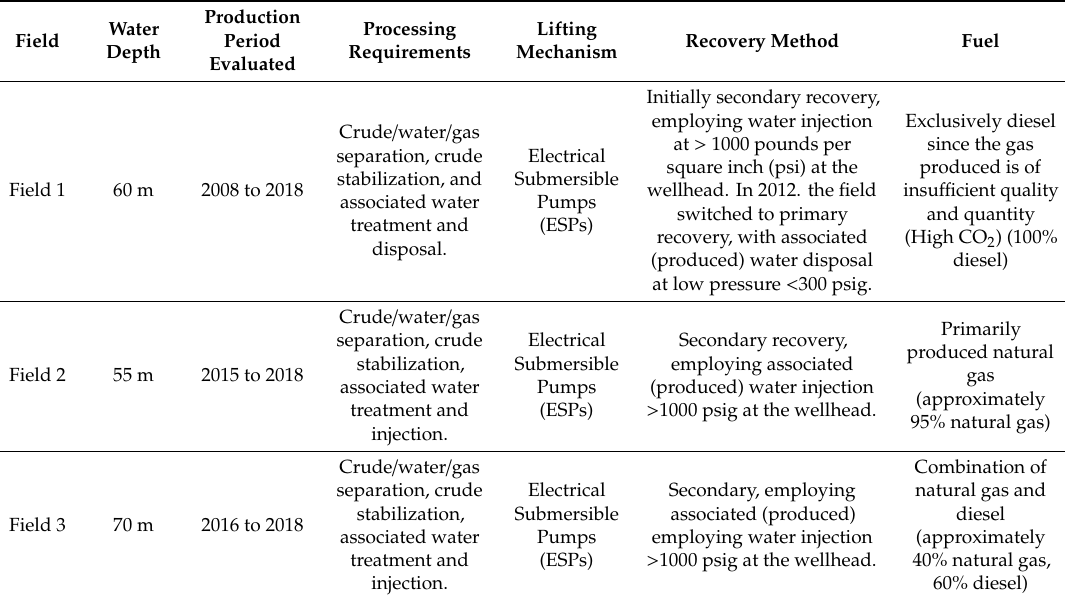
Table 4. Summary of Case